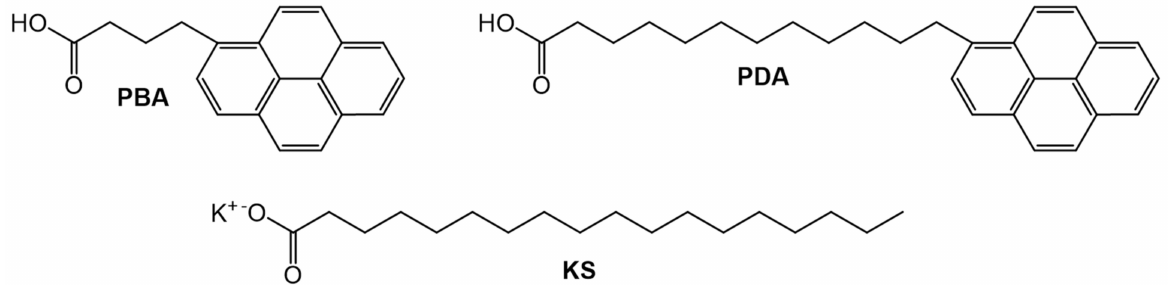
Figure 22. Molecular structures of PBA, PDA and